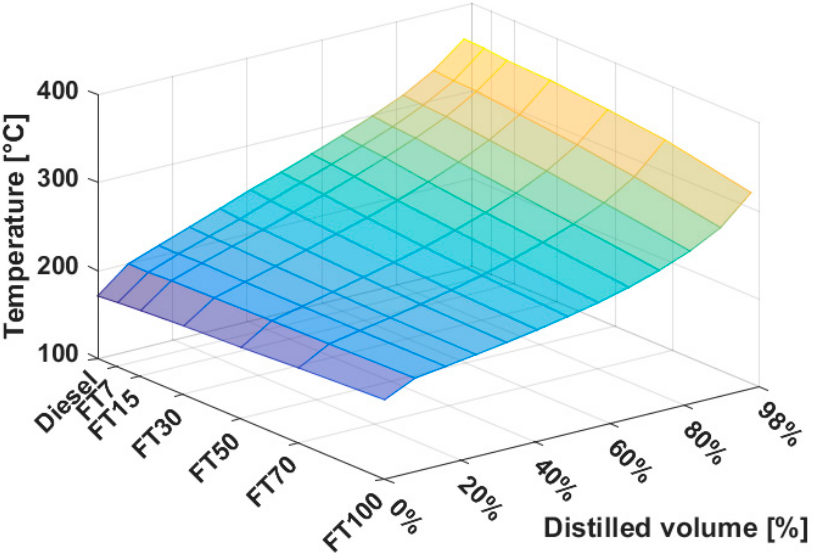
Figure 10. Distillation curve of FT − diesel mixtures.